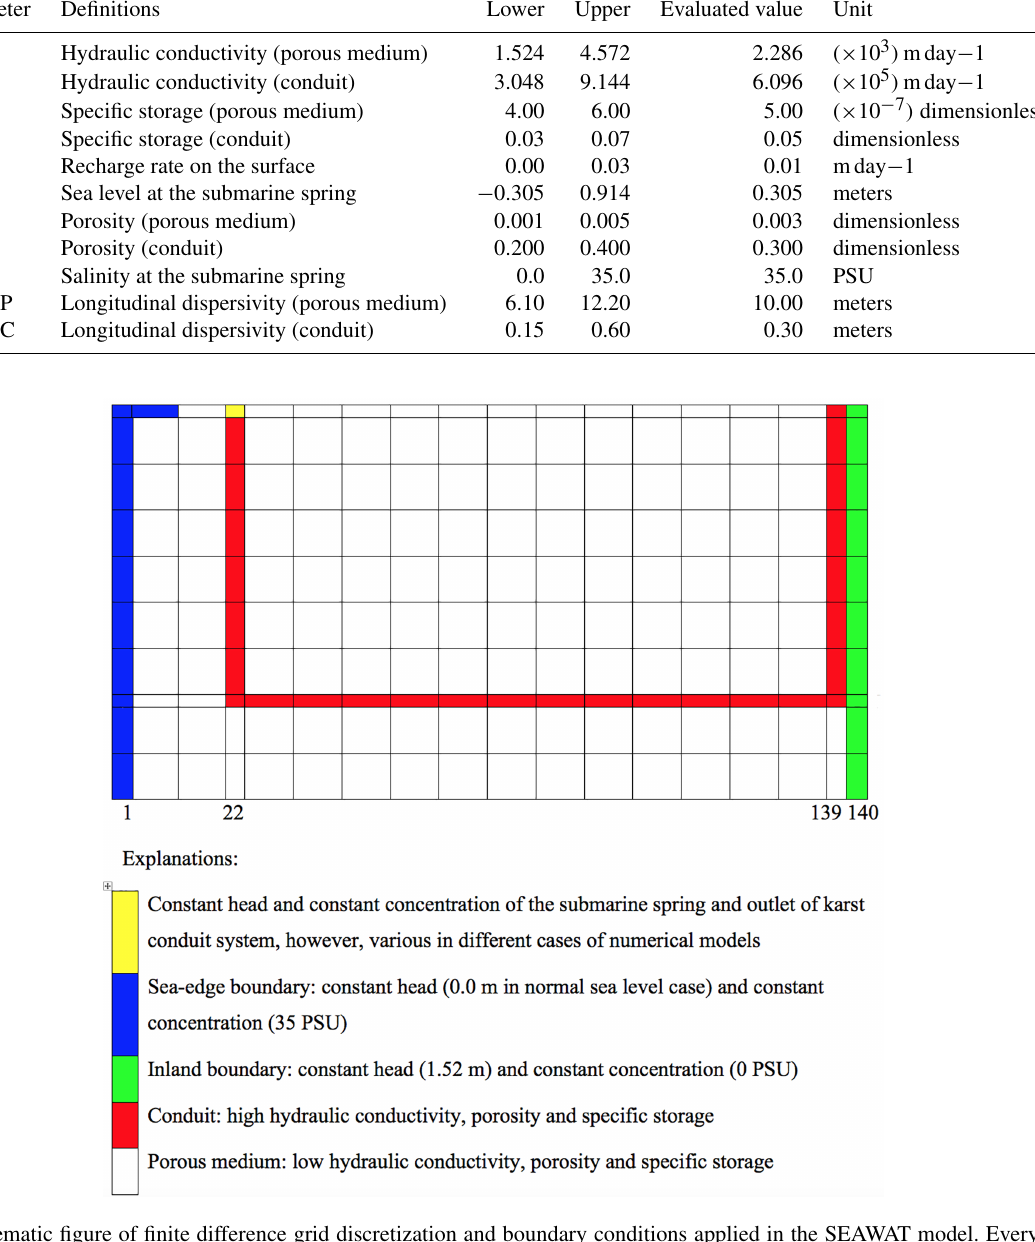
Figure 3. Schematic figure of finite difference grid discretization and boundary conditions applied in the SEAWAT model. Every cell rep- resents 10 horizontal cells and 4 vertical cells, except the boundary and conduit layer in color with smaller width. The submarine spring is located at column no. 22, layer no. 1, and the inland spring is located at column no. 139, layer no. 1. The conduit system starts from the top of column no. 22, descends downward to layer no. 29, horizontally extends to column no. 139, and then rises upward to the top through column no.